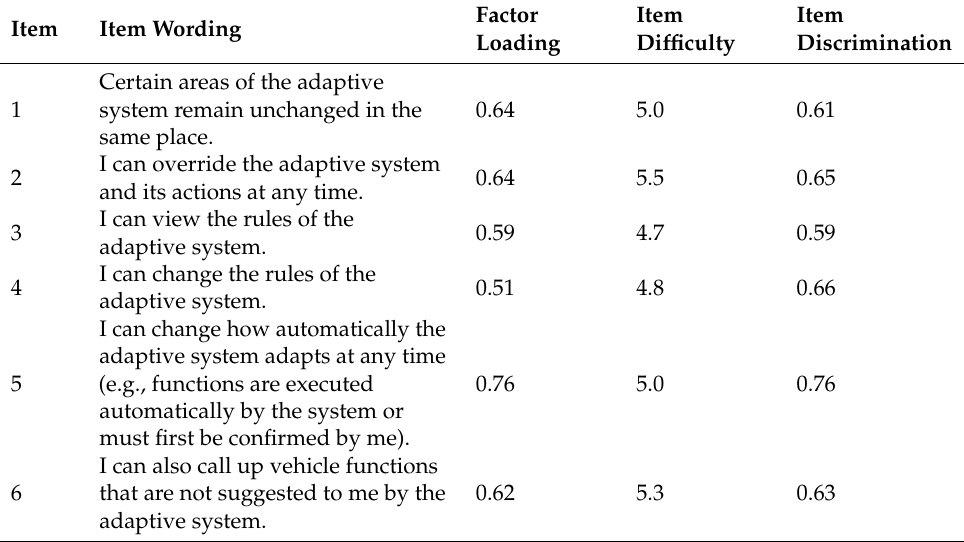
Table A4. Items of Factor 4 “User